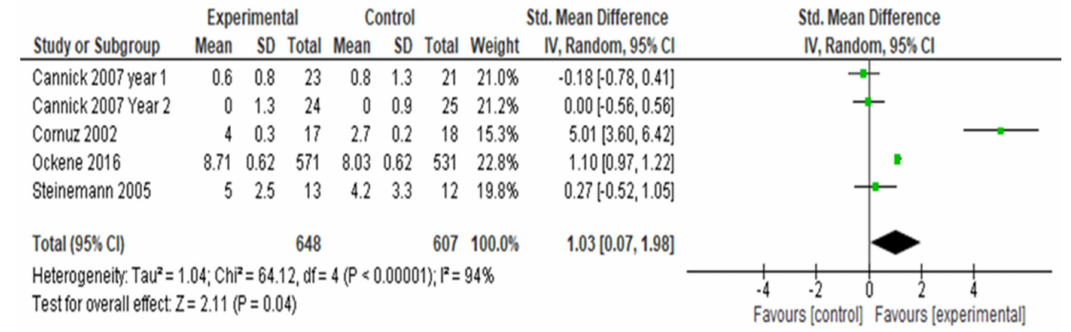
Figure 4. Forest plot for change in tobacco cessation counseling skills using the 5As with standardized or real patients.